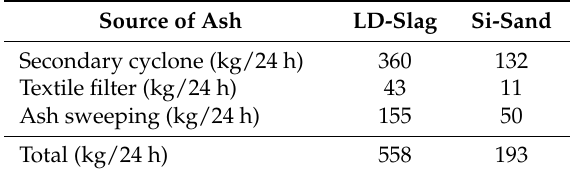
Table 6. Comparison of fly ash generation between LD-slag and silica